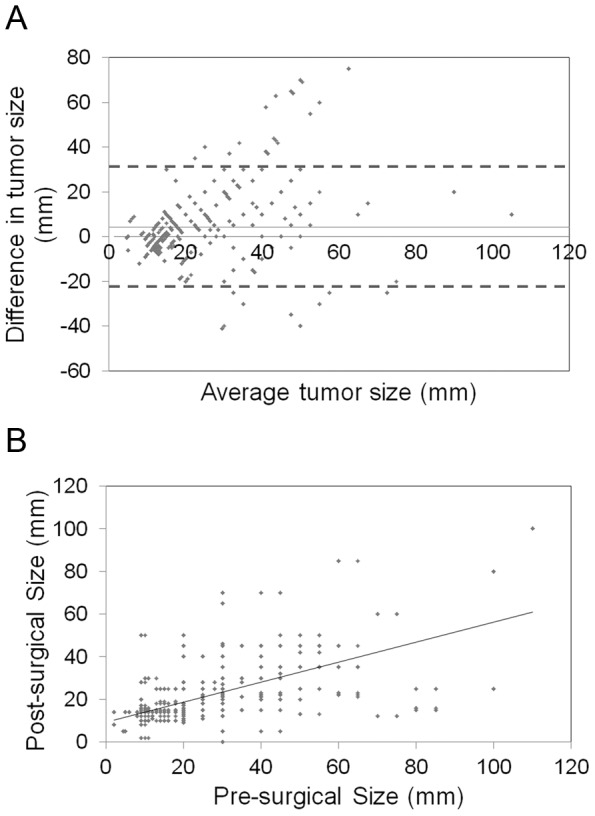
The association between pre-surgical and pathological tumor sizes in 1296 breast cancer patients.A. Bland-Altman plot of difference and average of pre- and post-surgical tumor sizes. B. Scatter plot and linear regression of the observed pre-surgical tumor size (x axis) and pathological measurement (y axis).